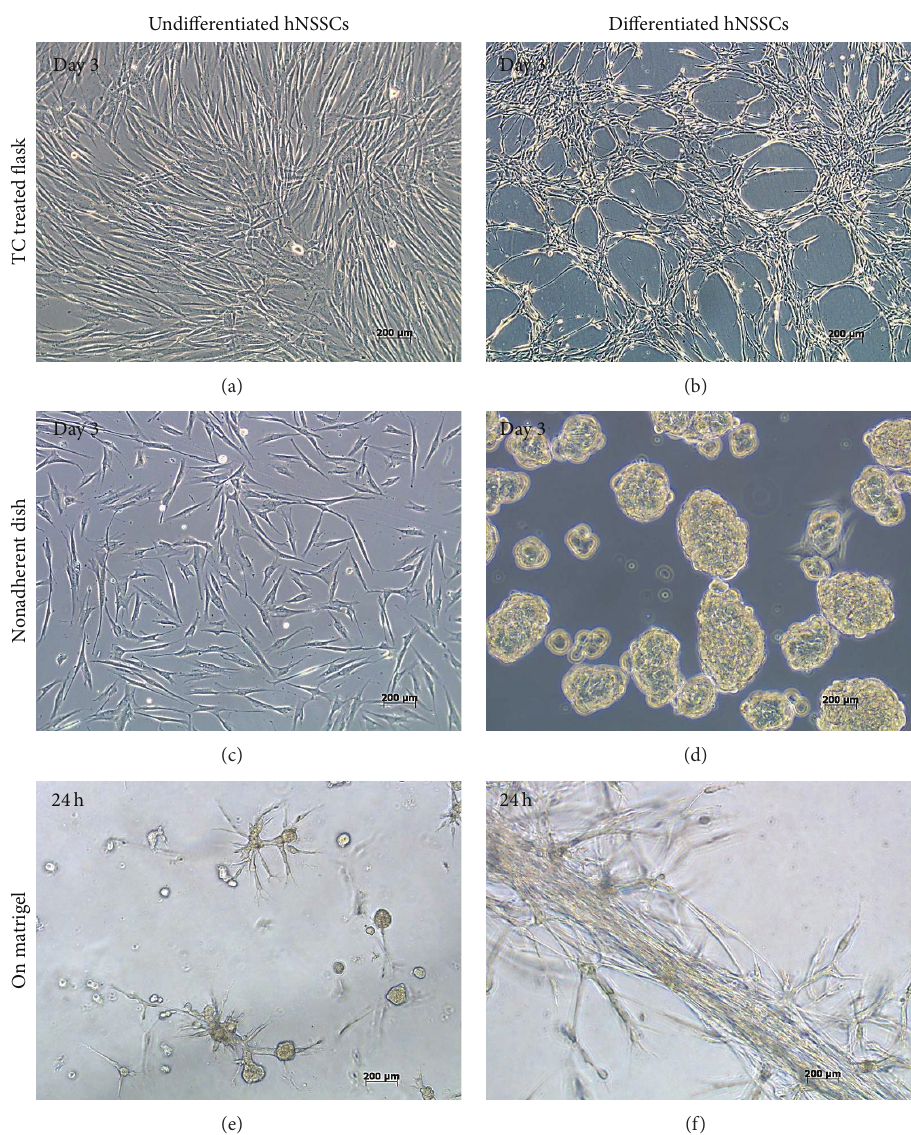
Figure 2: Undifferentiated and differentiated hNSSCs exhibit different morphological changes when cultured on different surfaces. Undifferentiated and differentiated hNSSCs were cultured on tissue culture-treated (a and b), or untreated (c and d) or on matrigel (e and f). Morphological changes were subsequently observed and imaged (Bar = 200 𝜇